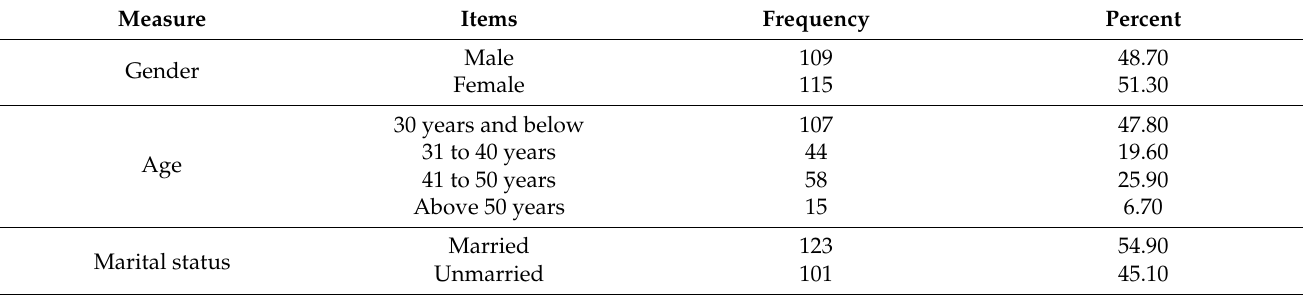
Table 1. Participants’